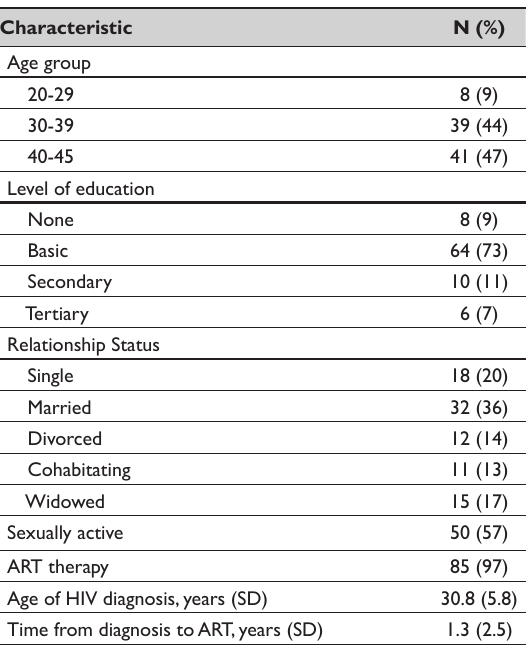
Table 1: Demographic characteristics of